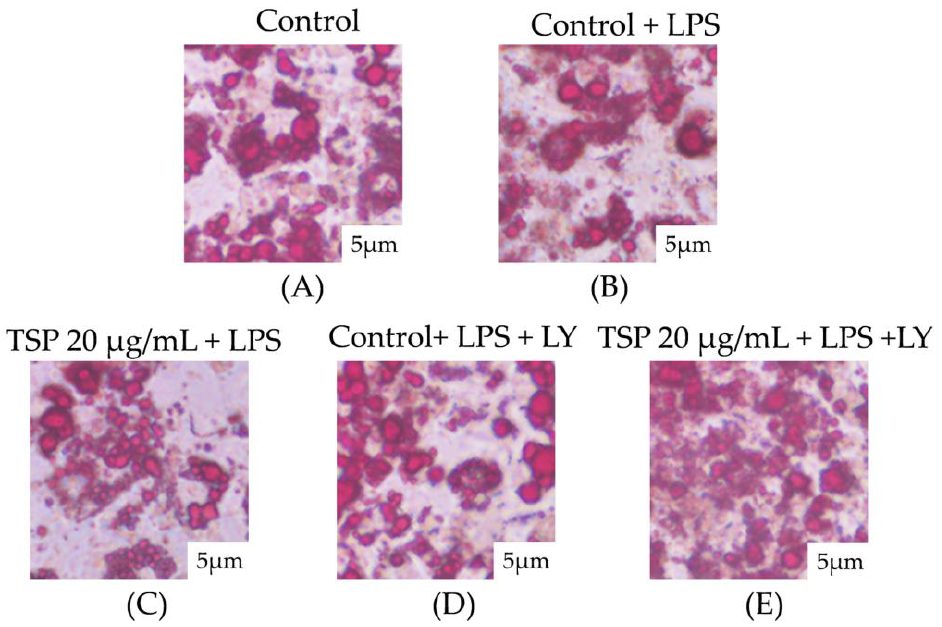
Figure 5. Oil red O staining diagram of the effect of TSP on lipid accumulation in adipocytes under inflammatory stress and inhibitor LY: ( A ) blank control group, ( B ) positive control group under inflammatory conditions, ( C ) Effect of TSP (20 µg/mL) on positive control group, ( D ) Positive control group with inhibitor LY; ( E ) Effect of TSP on positive control group supplemented with inhibitor LY.